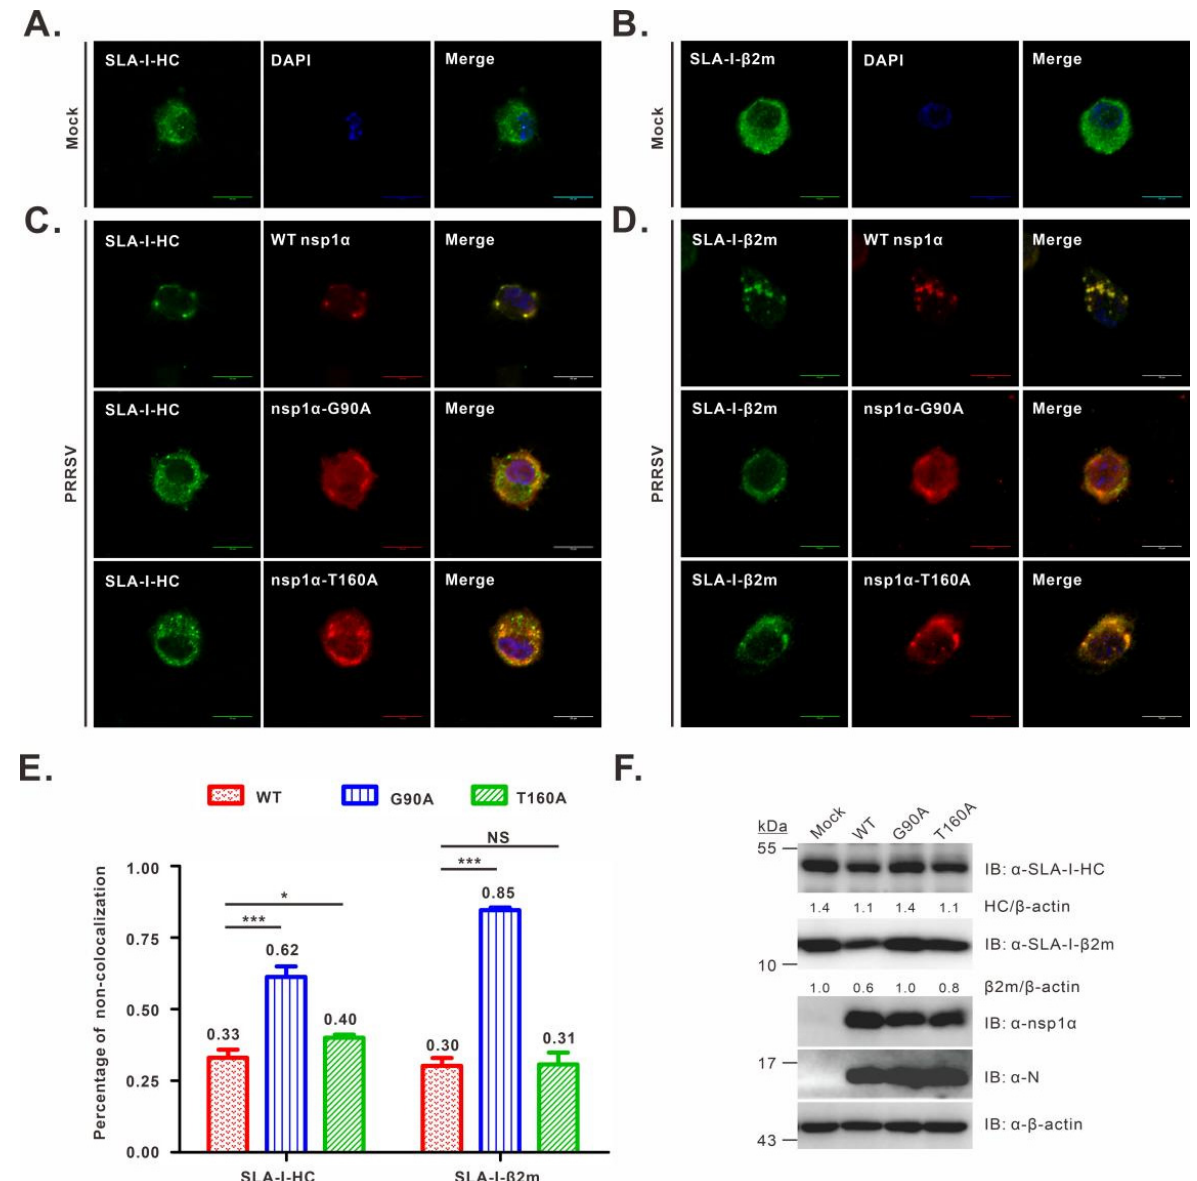
Figure 4. Co-localization analysis of SLA-I with nsp1 α or its derivatives in PRRSV-infected PAMs. PAMs grown on coverslips in 12-well plates were mock-infected with RPMI 1640 ( A , B ) or infected